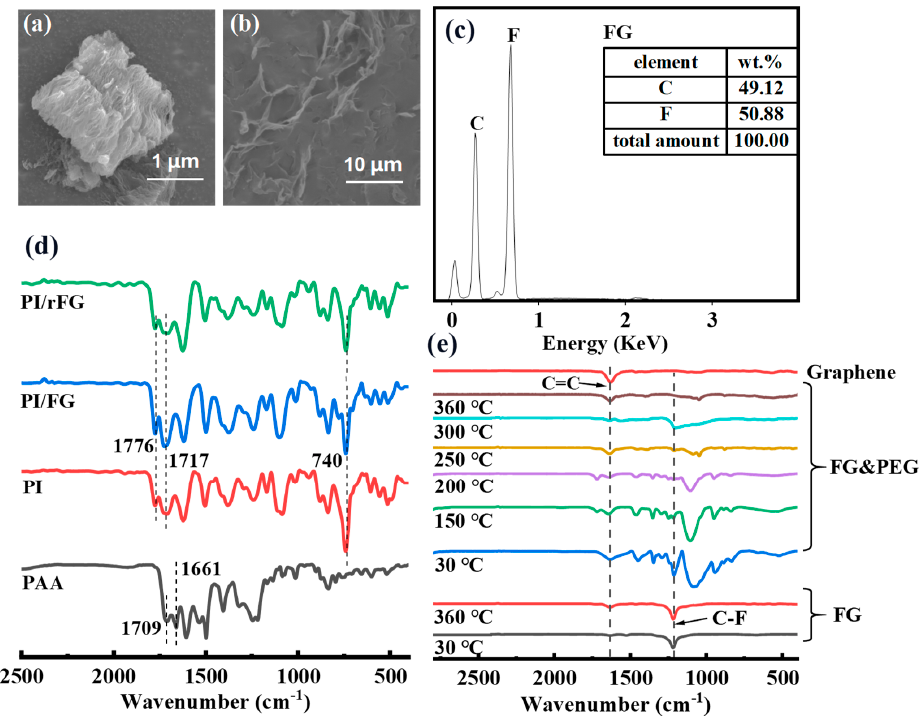
Figure 2. The characterization of the FG, PEG–FG and PI composite films. ( a , b ) the SEM image of the FG; ( c ) the EDS of the FG; ( d ) the FT-IR spectra of the PAA, PI, PI/FG-8% and PI/rFG-8% composite films; ( e ) the FT-IR spectra of graphene, FG–PEG and FG. The properties of the PI composite films are related to various factors, such as the degree of imidization, the dispersion of the filler particles, the components, etc. The pro- cess of forming PI by dehydrating PAA into a ring is called imidization. As shown in